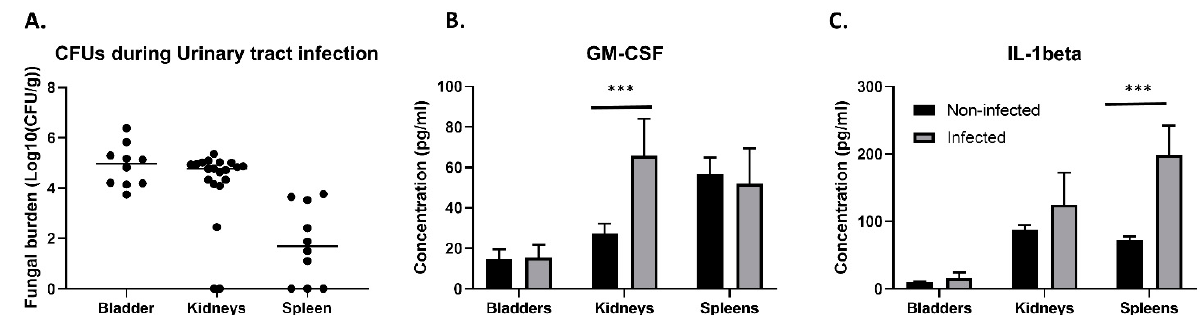
Figure 1. C. glabrata colonization of tissues in the UTI model and subsequent immune response. ( A ) Ten mice were chal- lenged with 2.5 × 10 8 C. glabrata cells directly into an emptied bladder. Three days post infection, mice were euthanized, and colony forming units (CFUs) were determined in the bladder, the kidneys, and the spleen. ( B ) Production of GM-CSF; ELISA was carried out for supernatant of homogenized, infected bladders, kidneys, and spleens and their non-infected counter parts. Colonization of the kidneys causes significantly increased production of the macrophage attraction factor GM-CSF (unpaired t -test, p = 0.000635). ( C ) Colonization of the spleen causes increased production of IL-1beta (unpaired t -test, p = 0.007897). Error bars show standard deviations. Significance: **** p < 0.0001.